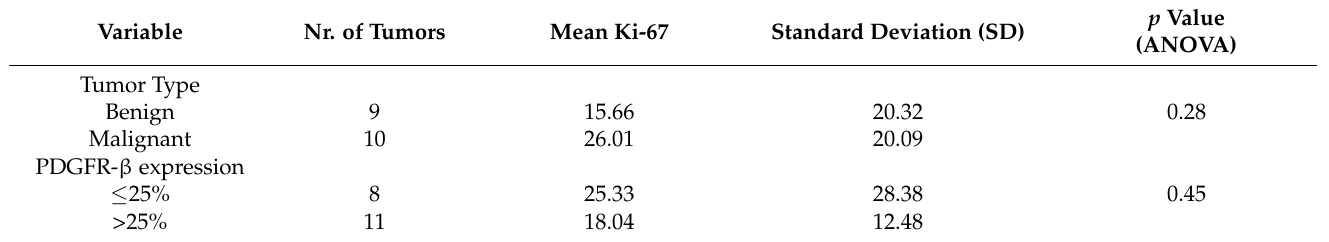
Figure 1. Immunohistochemical PDGFR- β staining in canine cutaneous PNST (×200): ( a ) MPNST with weak cytoplasmic staining in more than 25% of neoplastic cells; ( b ) MPNST with intense cyto- plasmic staining in more than 25% of neoplastic cells.